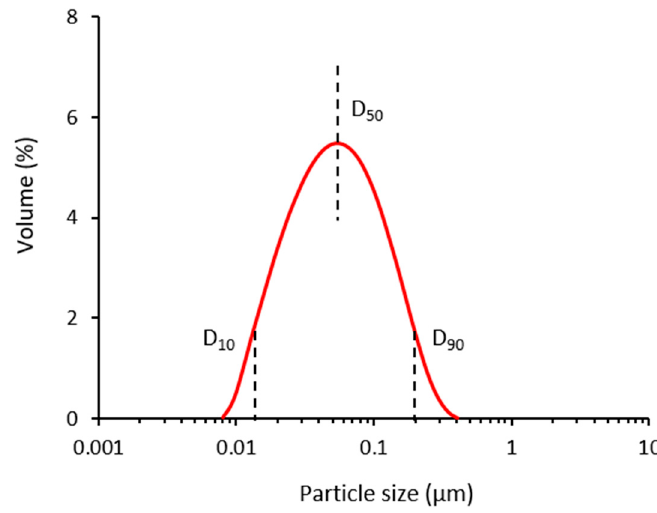
Figure 1. A typical size distribution curves representing D 10 , D 50 , and D 90 .